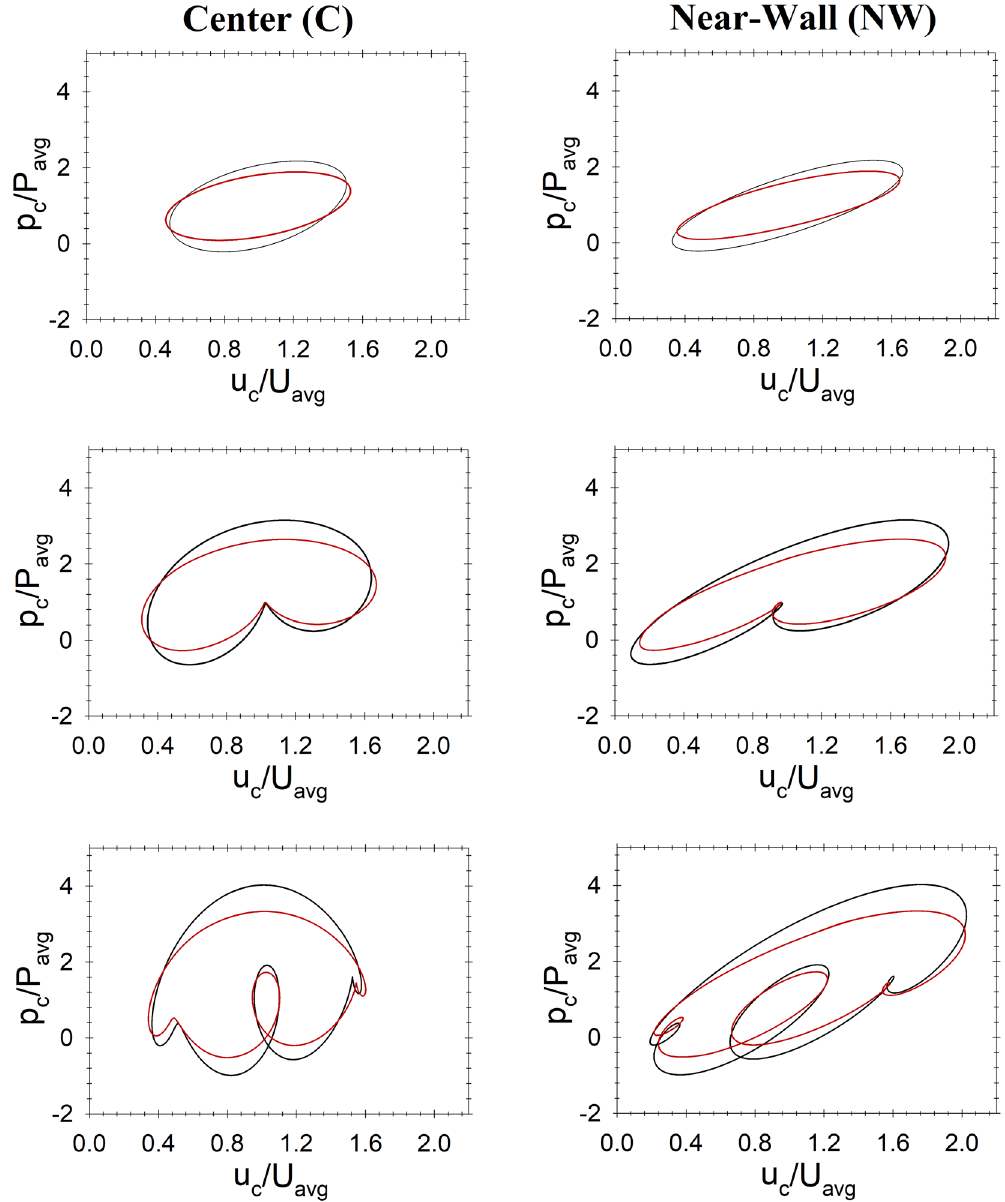
Figure 3. Non-dimensional phase diagrams of pulsatile flow showing the effect of harmonics (one, two and three harmonics depicted in the top, middle and bottom rows, respectively). Black and red lines indicate Newtonian (N) and Carreau–Yasuda (CY) fluid models, respectively. Spatial non-similarity is shown by comparing the phase diagrams obtained at a center point (left column) and a near-wall pint 10 µ m from the wall (right column). Average values are calculated over one cycle for each